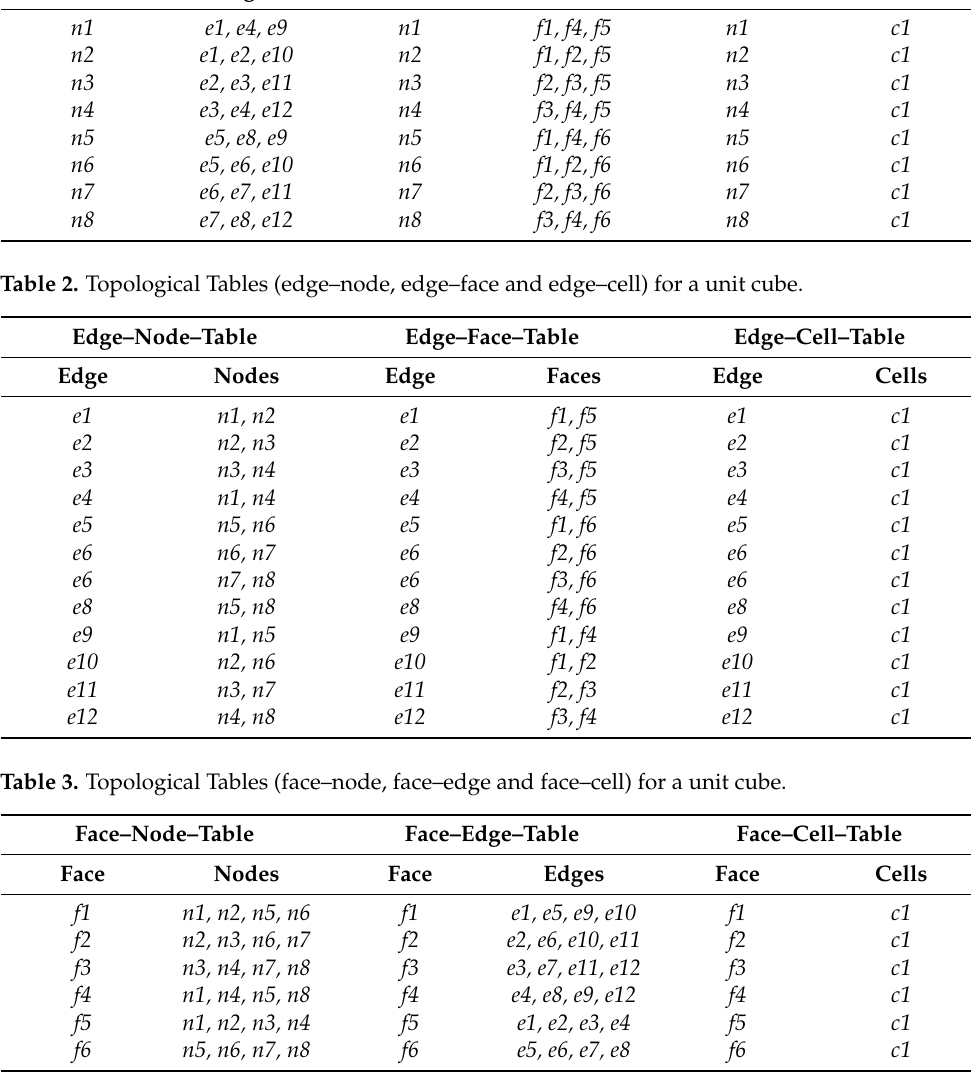
Table 4. Topological Tables (cell–node, cell–edge and cell–face) for a unit